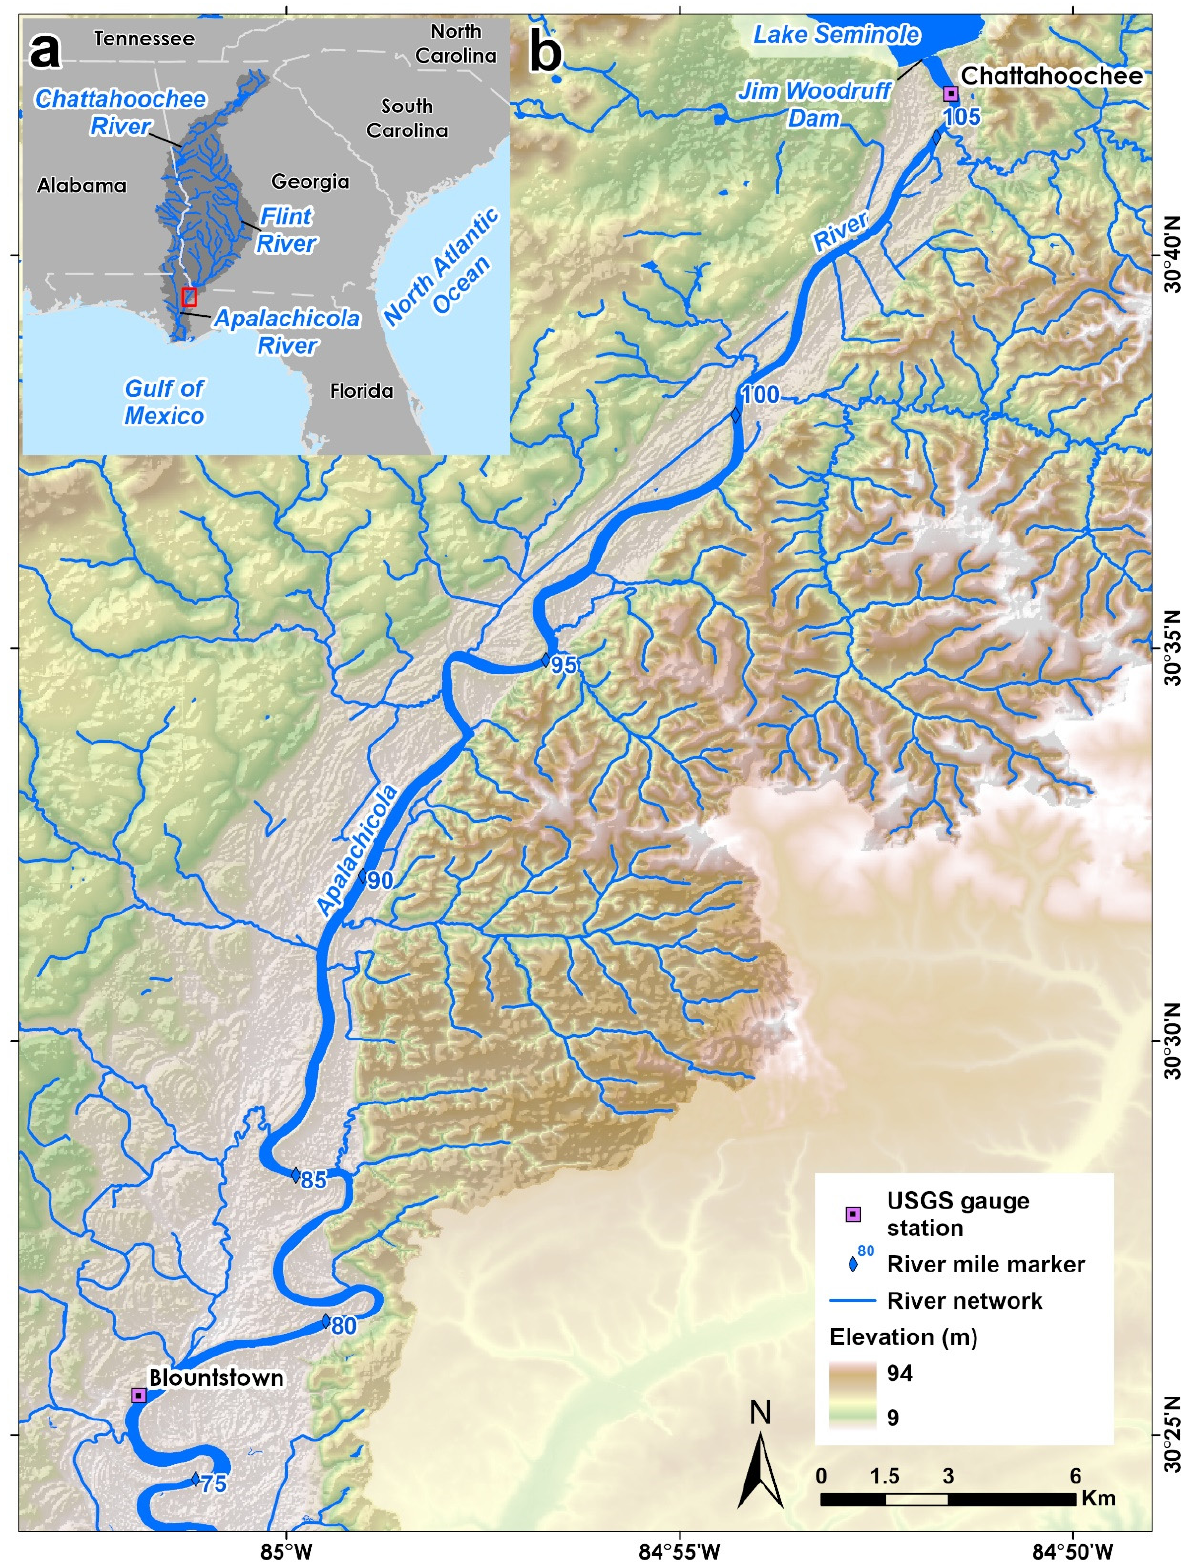
Figure 1. Study area map showing floodplain elevation, USGS gauge stations, and river mile markers of the upper Apalachicola River ( b ), which is part of the ACF basin ( a ).